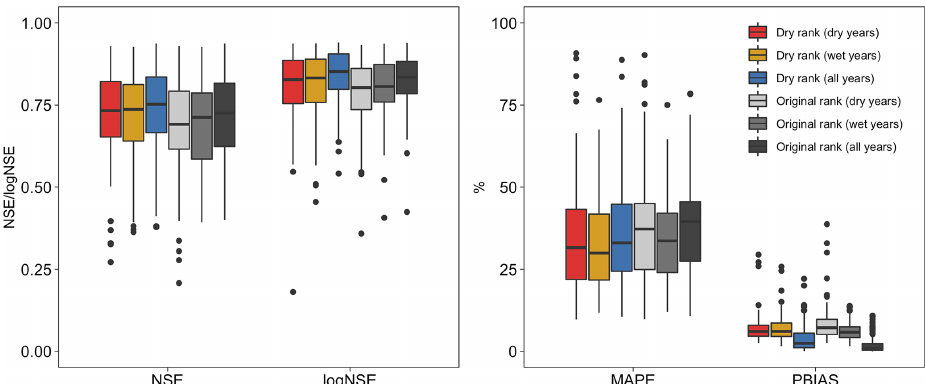
Figure 2. Model performance of the top-ranked parameter set across the selected catchments between parameter sets ranked based on the 10 driest years (dry rank) and the original LHS500 rank (original rank). Comparison is made for the top-ranked parameter set in either the dry rank or the original rank when the model performance metrics are calculated for the 10 driest years, 10 wettest years, and all years.